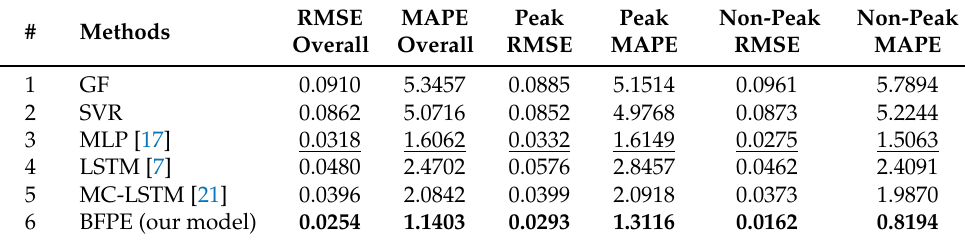
Table 1. Summary of performance outcome on NASA dataset.